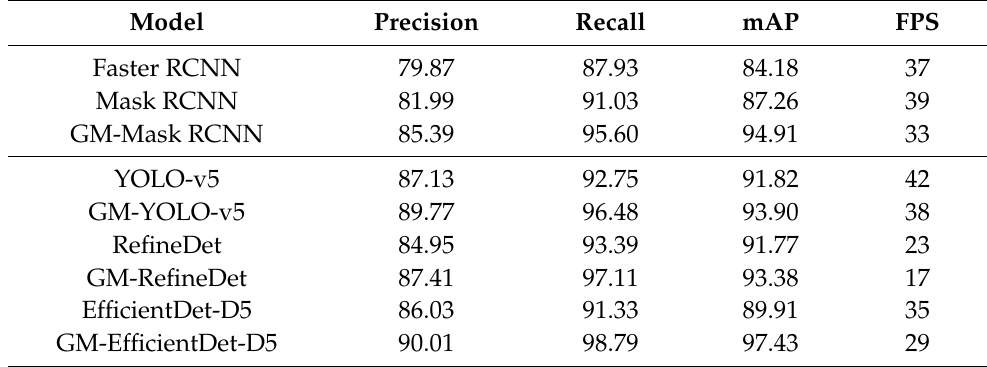
Figure 13. Demonstration of GM-EfficientDet-D5’s effectiveness. ( A ) is large scale; ( B ) is medium scale; ( C ) is large scale. Table 4. Performance of different models (in %).